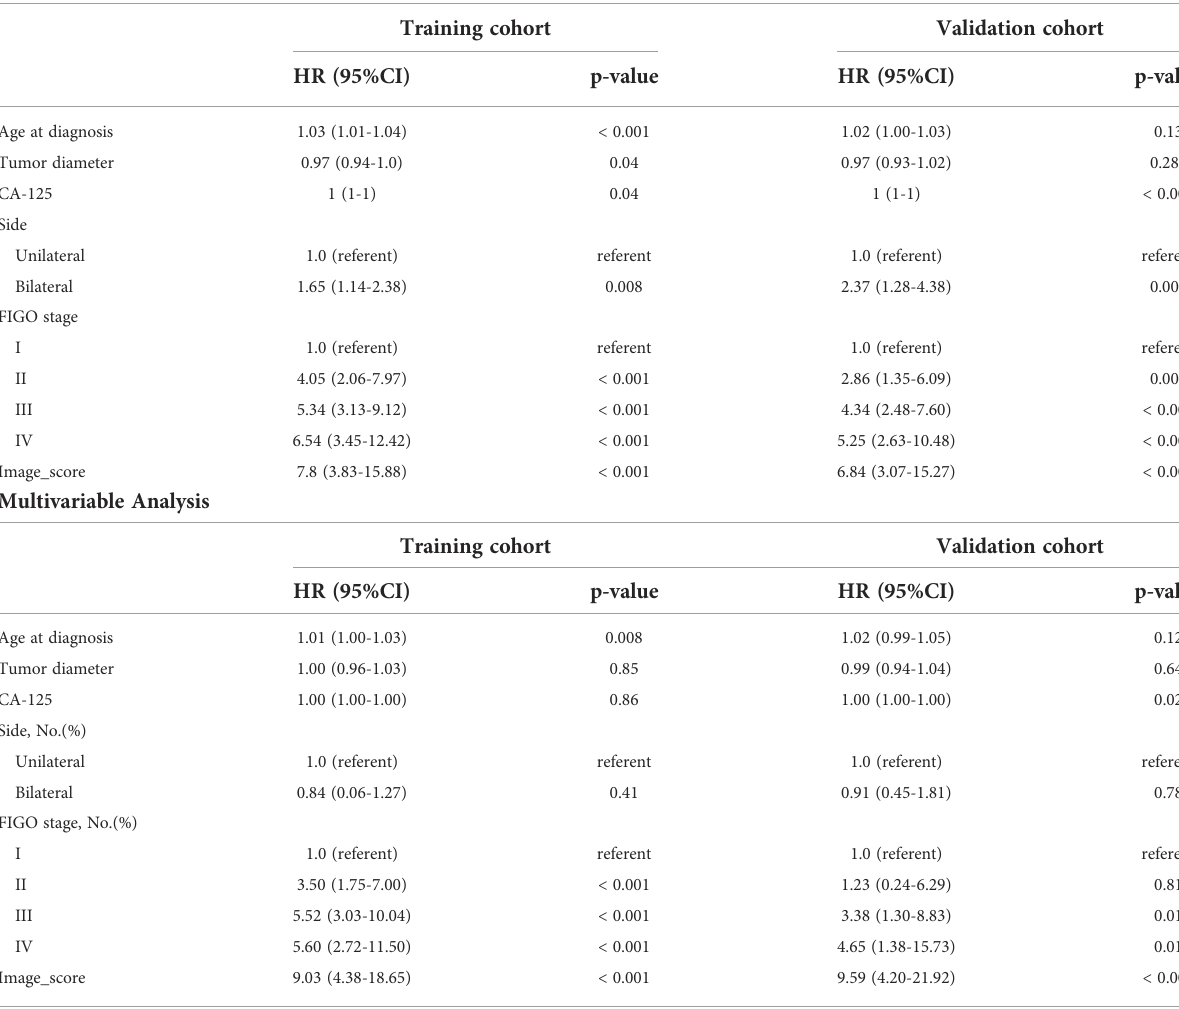
TABLE 2 Univariable and Multivariable Analyses of Overall Survival in training and validation cohorts. Univariable